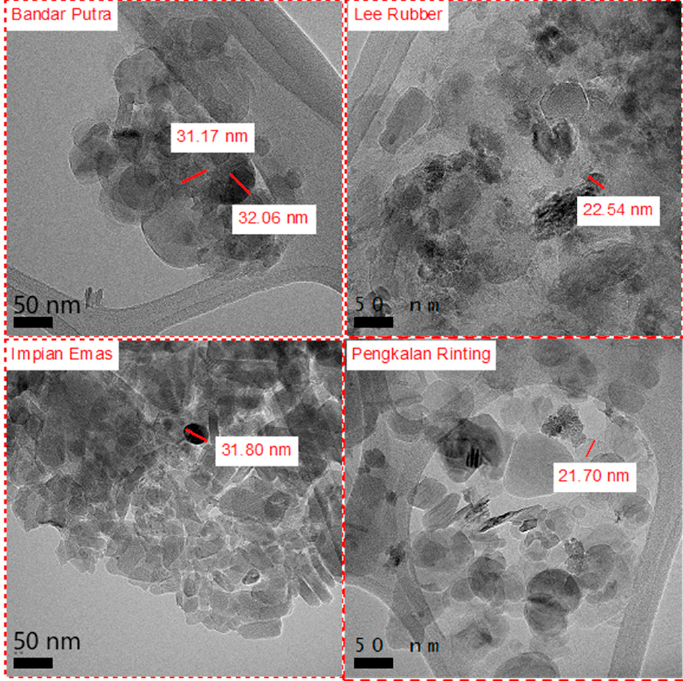
Figure 3. TEM image displaying the nano-size of Ag in water samples.